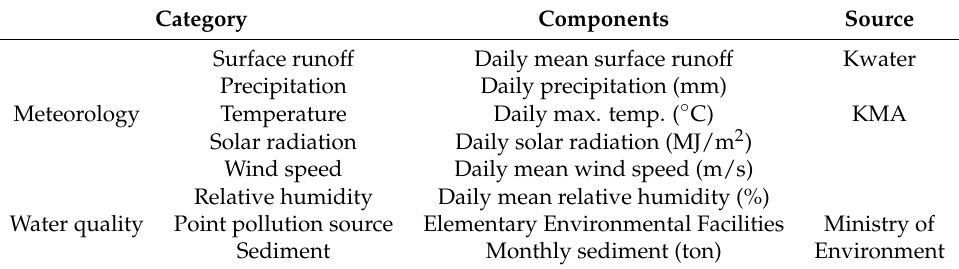
Table 2. Meteorological and environmental